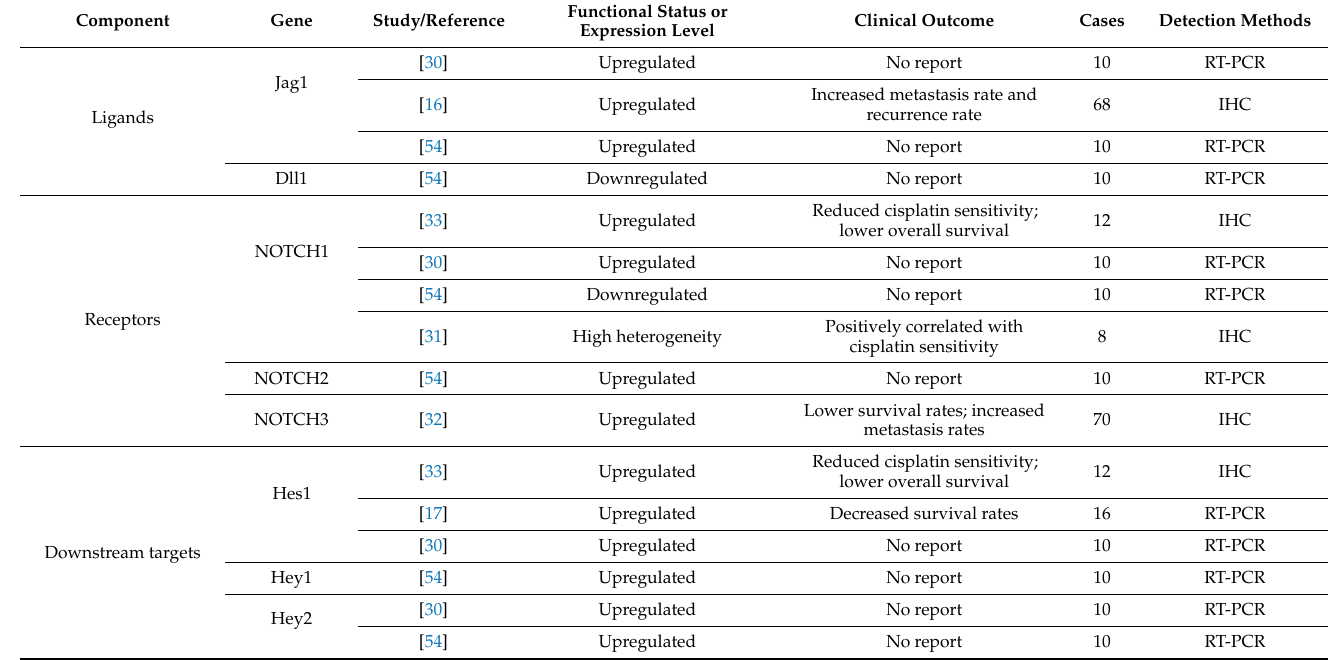
Table 1. Clinical significance and expression level of NOTCH signaling pathway in